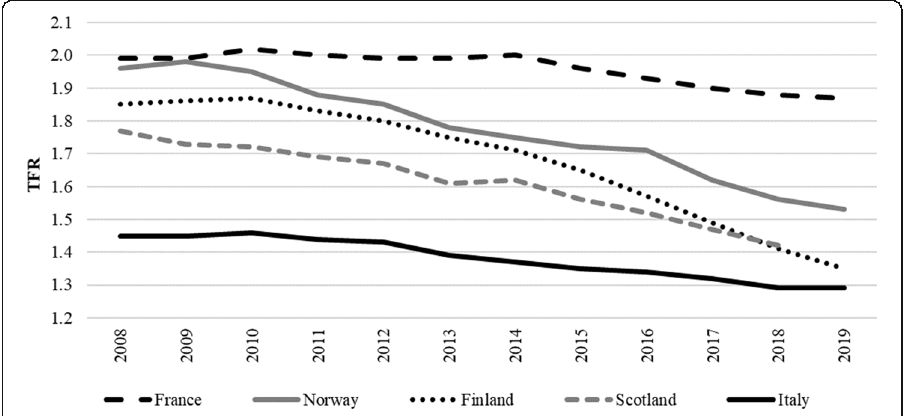
Fig. 1 A few examples of the contemporary fertility winter in Europe. Total Fertility Rate (TFR) for Finland, France, Italy, Norway, and Scotland